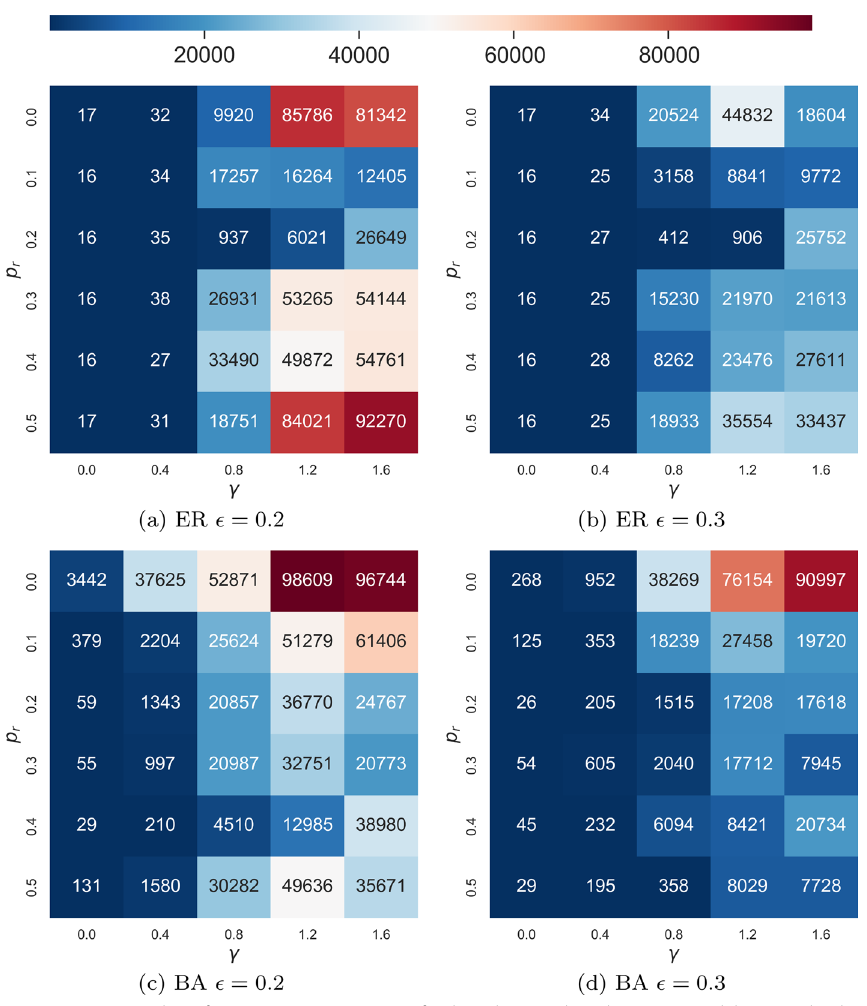
Fig. 9 Average number of iterations at convergence for the Adaptive Algorithmic Bias model on Simplicial Complexes. The average number of iterations at convergence for the Adaptive Algorithmic Bias model on Simplicial Complexes as a function of γ and p r for a ǫ = 0.2 and b ǫ = 0.3 in a Erdős–Rényi graph and c , d in a scale-free Barabási–Albert graph. These values are averaged over 30